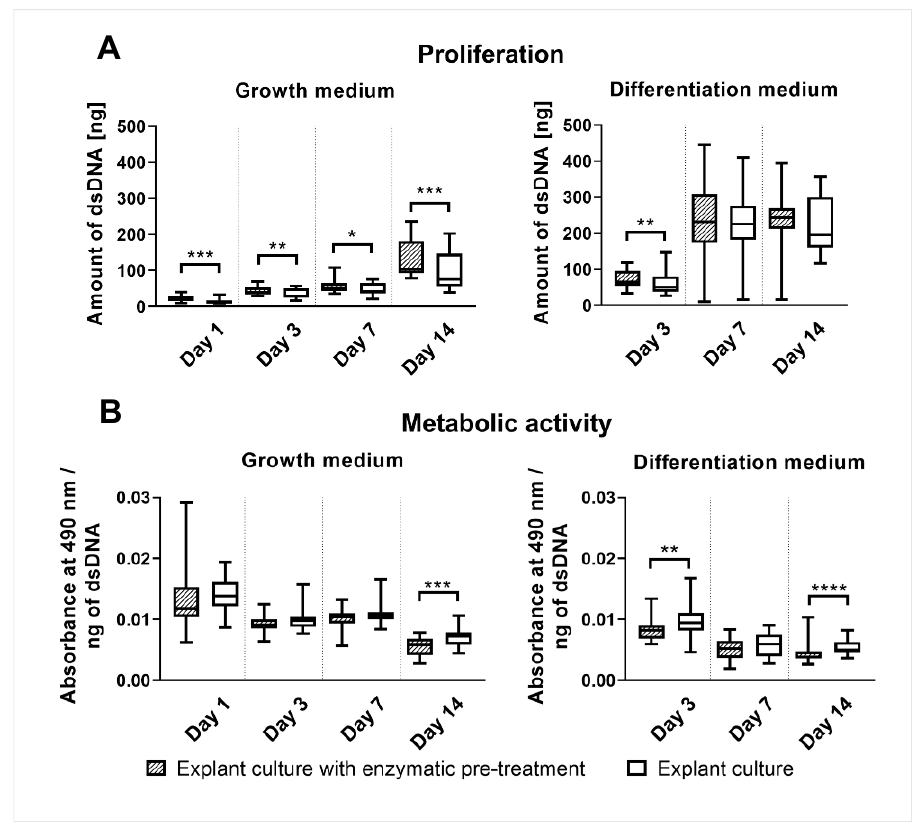
Figure 1. Proliferation ( A ) and metabolic activity ( B ) of rOBs isolated either by explant culture with enzymatic pre-treatment or by explant culture. Proliferation assessed by dsDNA quantification and metabolic activity measured by MTS assay and normalized to the estimated amount of rOBs were measured on days 1, 3, 7, and 14. Cells were cultured either in the growth or in the differentiation medium. The statistical difference is marked as a link above the groups. * p < 0.05, ** p < 0.01, *** p < 0.001, **** p < 0.0001.